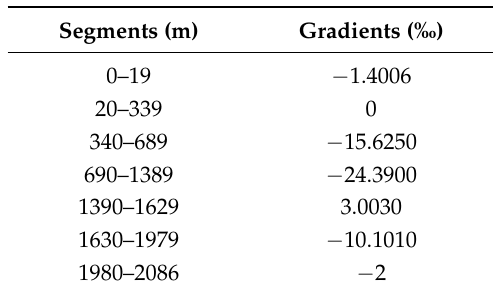
Table 2. Gradient information between Jinghai and